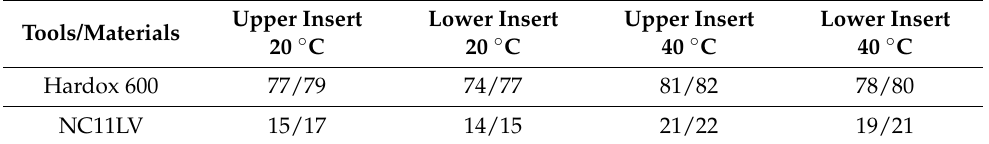
Table 2. The impact strength results for Hardox 600 and NC11LV steels (KV in J).